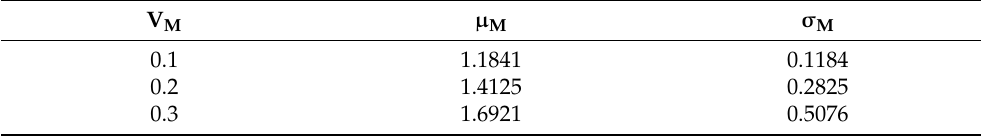
Table 1. Parameters of the material